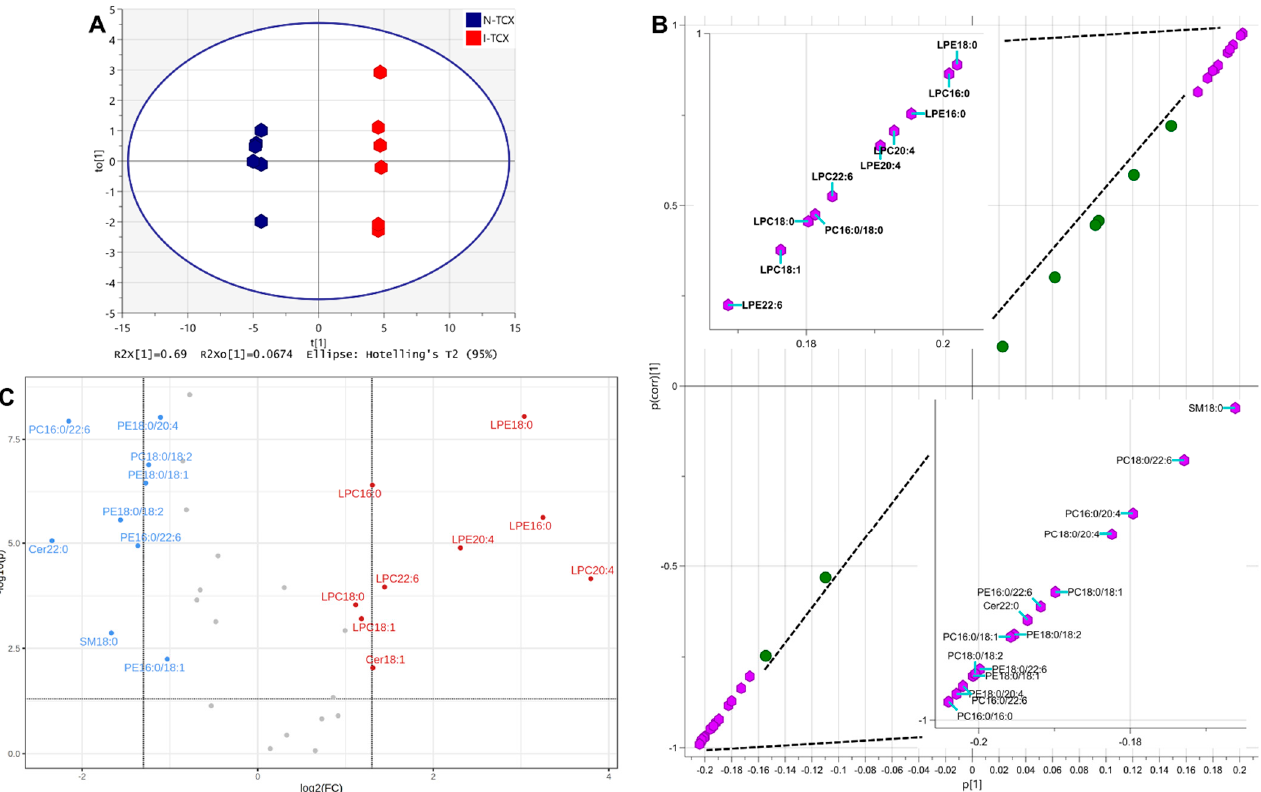
Figure 4. ( A ): The scatter plot of OPLS-DA on lipids in normal temporal cortex (N-TCX) and ischemic